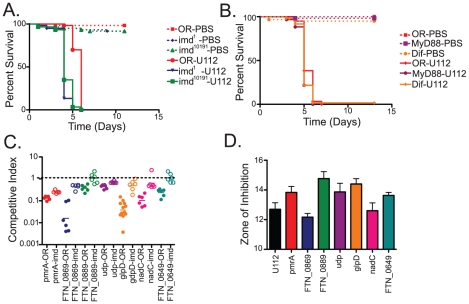
Negative selection screens in Drosophila immunity mutants identify F. novicida mutants that help the bacteria resist the imd-regulated host innate immune response.Survival of Toll and imd pathway mutants infected with F. novicida at 29°C. (A) Two null alleles of imd, imd10191 and imd1 backcrossed to OR backgrounds were tested, and both are significantly different from OR flies with log-rank test P values of >0.0001. (B)The Toll pathway is represented by loss of function alleles of two Toll pathway members, Dif and MyD88. Neither are statistically different from wild-type with log-rank test P values of 0.0866 and 0.0582 respectively. (C) Confirmation of mutants identified in the TraSH analysis as attenuated in wild-type flies and rescued in imd mutant flies. All rescues are statistically significant as measured by two-tailed t-tests, with P values of pmrA = 0.0006, FTN_0869 = 0.0001, FTN_0889 = 0.0113, udp = 0.0004, glpD<0.0001, nadC = 0.0465, and FTN_0649 = 0.0030. Horizontal lines indicate the geometric means of the samples. (D) Sensitivity of imd rescue mutants to Polymyxin B as measured by disk diffusion assay. Error bars represent standard error. pmrA, FTN_0889, udp, glpD and FTN_0649 are statistically significantly different from U112 with 2-tailed t-test P values of 0.0299, 0.0041, 0.0495, 0.0065 and 0.0447 respectively. FTN_0869 and nadC are not significantly different than wild-type U112, with P values of 0.1404 and 0.8130.